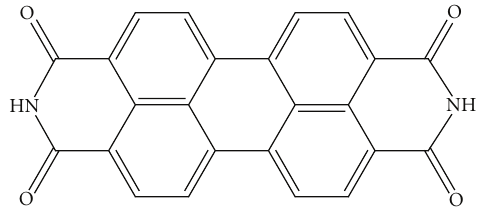
Figure 1: 3,4,9,10-perylene-tetracarboxylicacid-diimide, PTCDI.